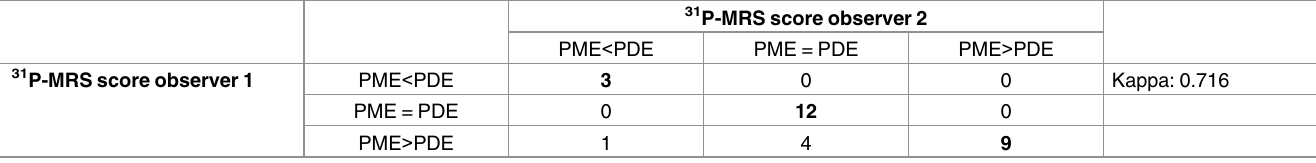
Table 2. Inter-observer variability between observer1 (W.K.) and observer2 (D.K.) for 31-phosphorus spectroscopy ( 31 P-MRS) scoring. Agreement is seen in 24/29 tumors (83%; kappa: 0.716). PME = Phosphomonoesters. PDE =